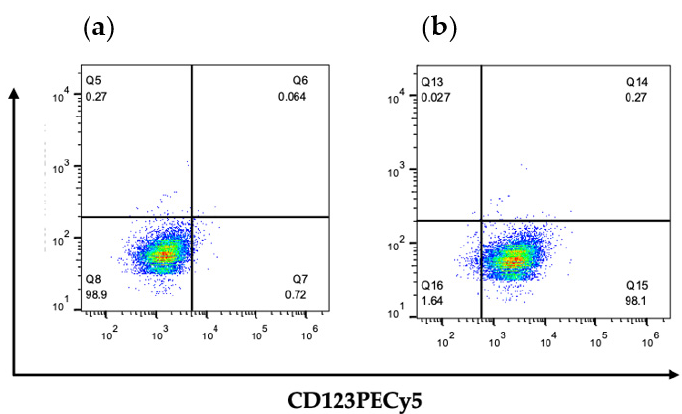
Figure 3. Surface expression of CD123 on KG-1a cells. Cells were stained with ( a ) isotype-matched control antibody or ( b ) CD123PECy5 antibody. Stained cells were assessed through flow cytometry.